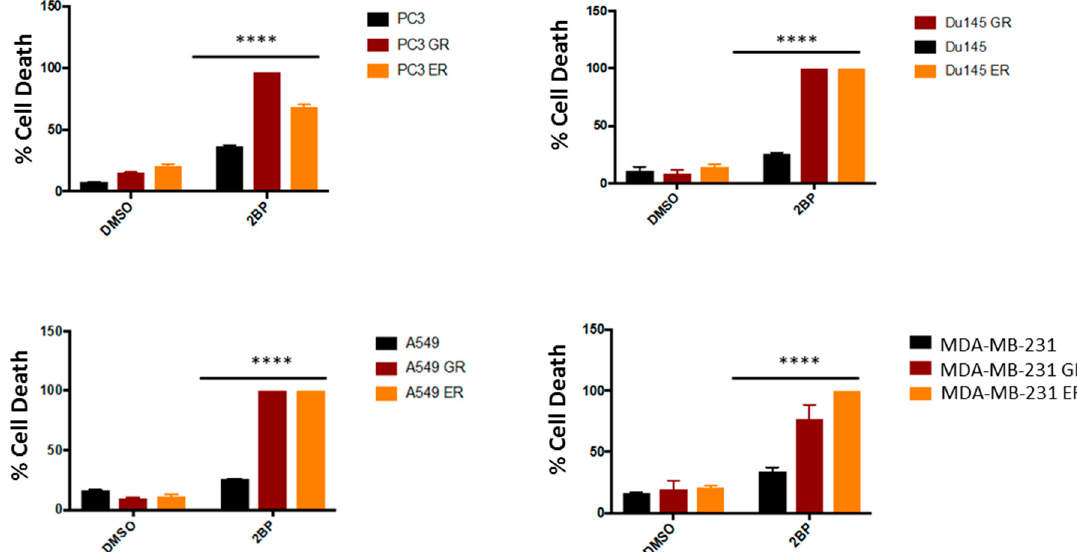
Figure 5. Inhibition of palmitoylation increases cytotoxicity in EGFR-TKI-resistant cells. GR and ER cells were seeded on 6-well plates along with respective non-treated parental controls. Once the cells were 80% confluent, the cells were treated with 2-BP (4 µm) for 72 h in serum-free media. Equal volumes of cell suspension was incubated with 0.4% trypan blue to obtain 1:2 dilution. Cells were counted using hematocytometer and percent cell death calculated. Results were triplicated ± SD and were pooled into treatment groups. One-way ANOVA and Tukey’s multiple comparison test were used for statistical analyses, **** p ˂ 0.0001.